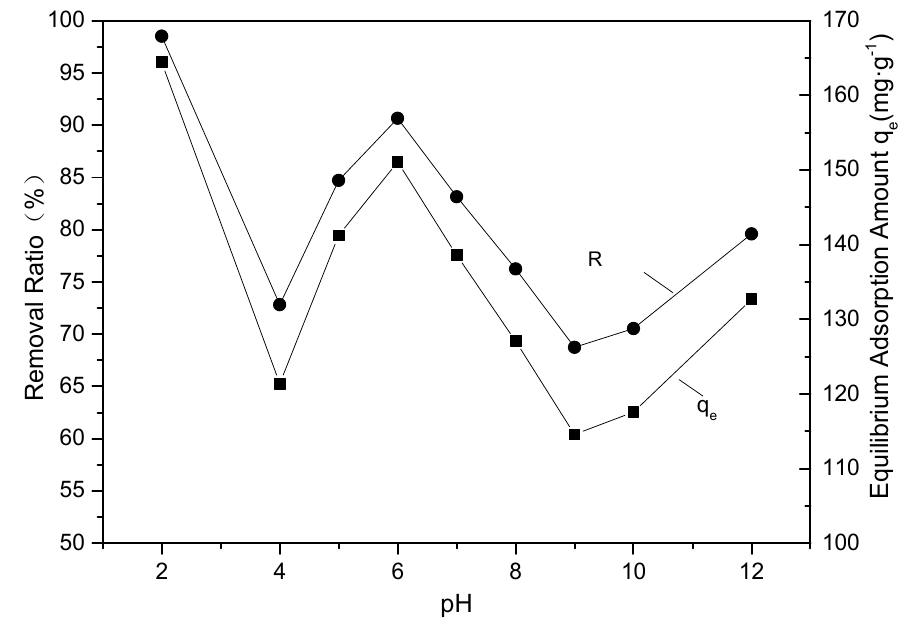
Figure 6. The effect of pH on adsorption of EBT by F-SAC.